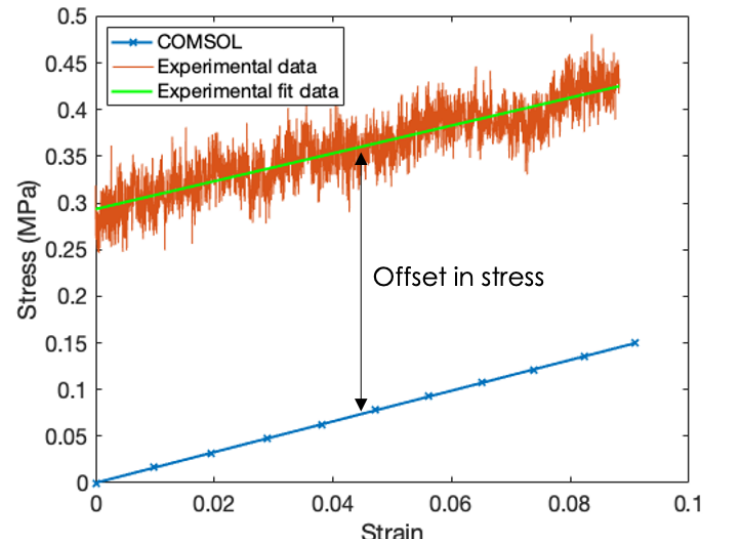
Figure 9. Validation of the SMP material subroutine stress prediction from the simulation (blue colour) with the experimental uniaxial-tensile-test-fit data (green colour) at 70 ◦ C with an applied load of 17.43 N. The offset in stress prediction was caused due to the generation of thermal stress upon heating the test